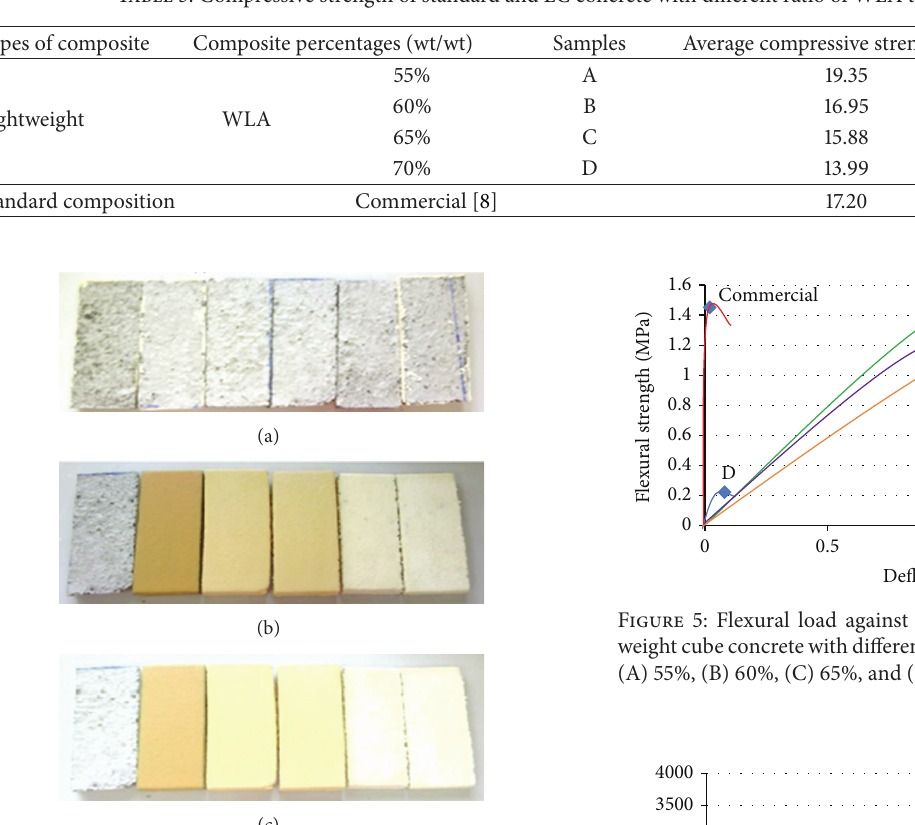
Table 3: Compressive strength of standard and LC concrete with different ratio of WLA to cement (wt/wt).